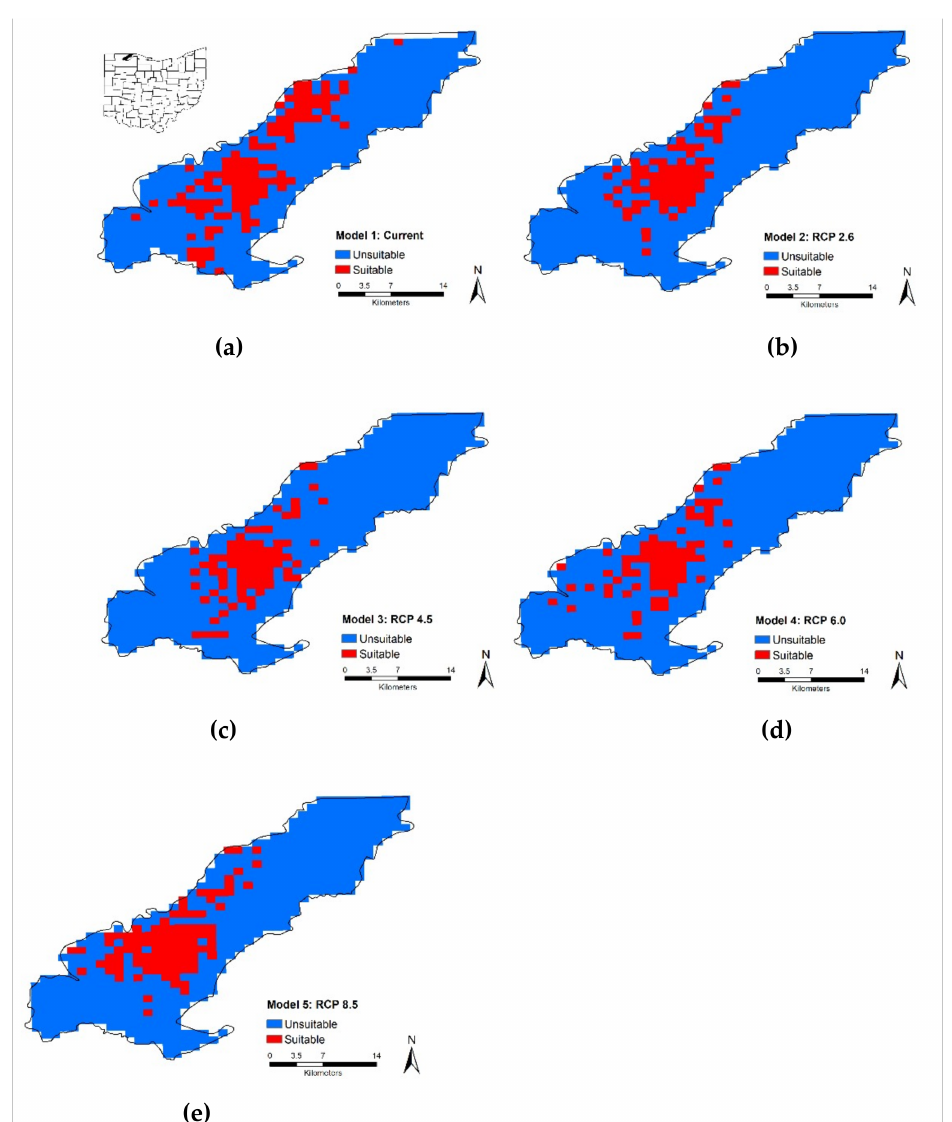
Figure 3. Climatic habitat suitability maps for T. c. carolina for five models, which include six bioclimatic variables, percentage of forest, percentage of early successional, and normalized di ff erence vegetation index (NDVI): ( a ) Model 1: Current; ( b ) Model 2: 2050 Representative Concentration Pathway (RCP) 2.6; ( c ) Model 3: 2050 RCP 4.5; ( d ) Model 4: 2050 RCP 6.0; and ( e ) Model 5: 2050 RCP 8.5 for